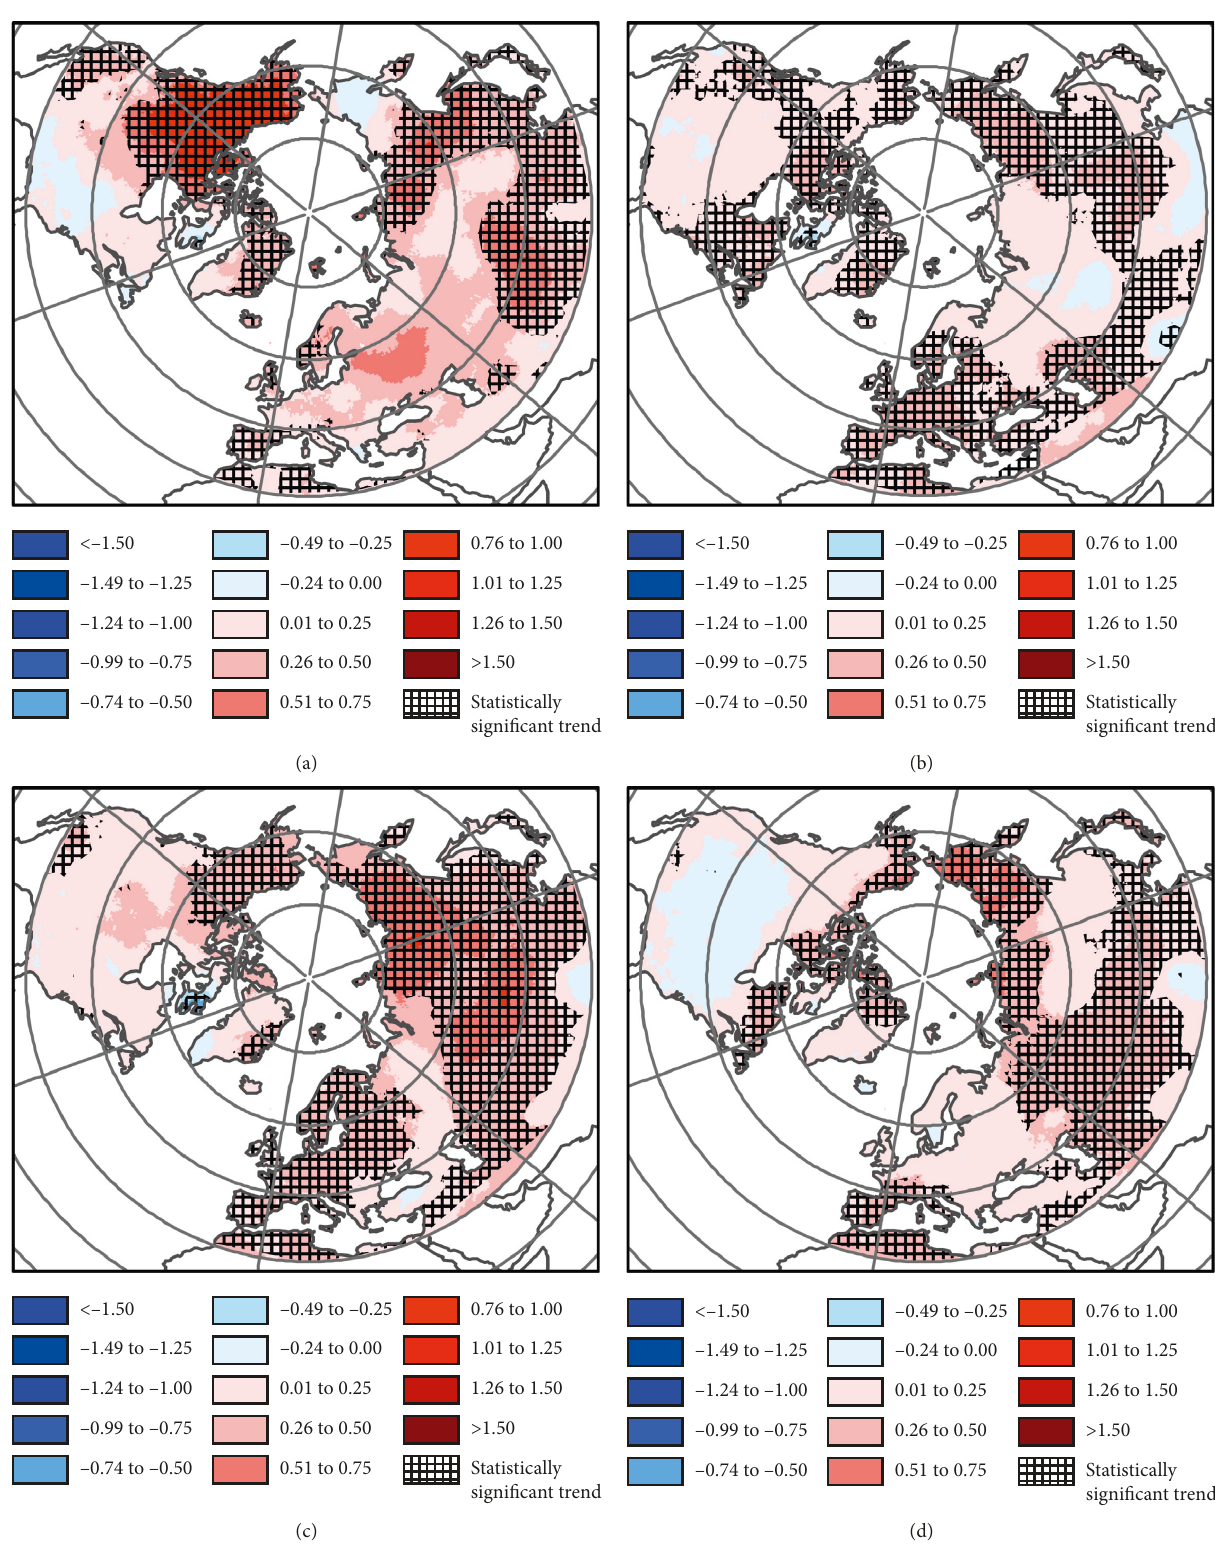
Figure 4: Sen’s slope trends of annual (a) minimum ( T ) and (b) maximum ( T ) monthly temperatures and temperature in (c) April min max ( T ) and (d) October ( T ) in the Northern Hemisphere above 30 ° N latitude in 1950–2015. The magnitude of trends is expressed as apr oct a change of temperature in ° C over 10